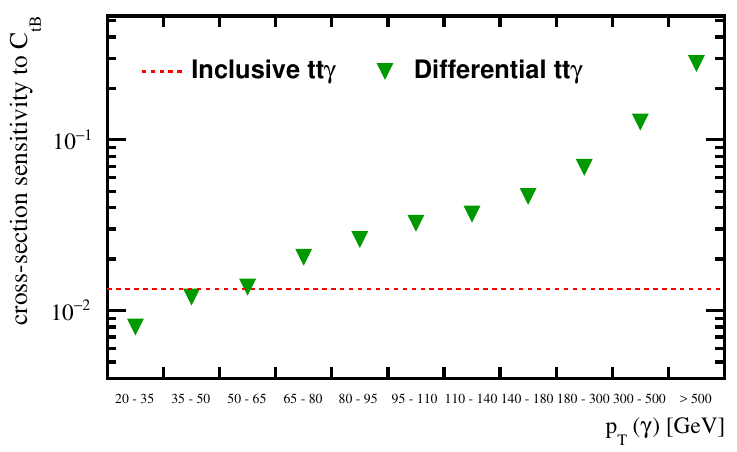
Figure 3 . The sensitivity of the di(cid:11)erential pp ! t (cid:22) t(cid:13) cross section to the operator coe(cid:14)cient C tB = (cid:3) 2 . The sensitivity is de(cid:12)ned as the relative change in the cross section due to a unit change in C tB = (cid:3) 2